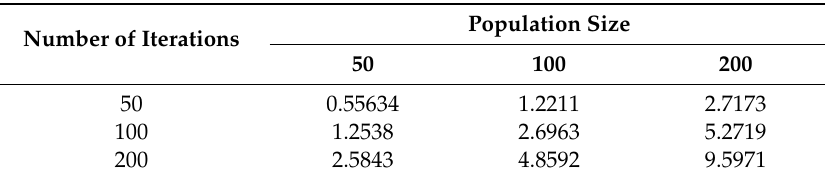
Table 3. Mean running time.